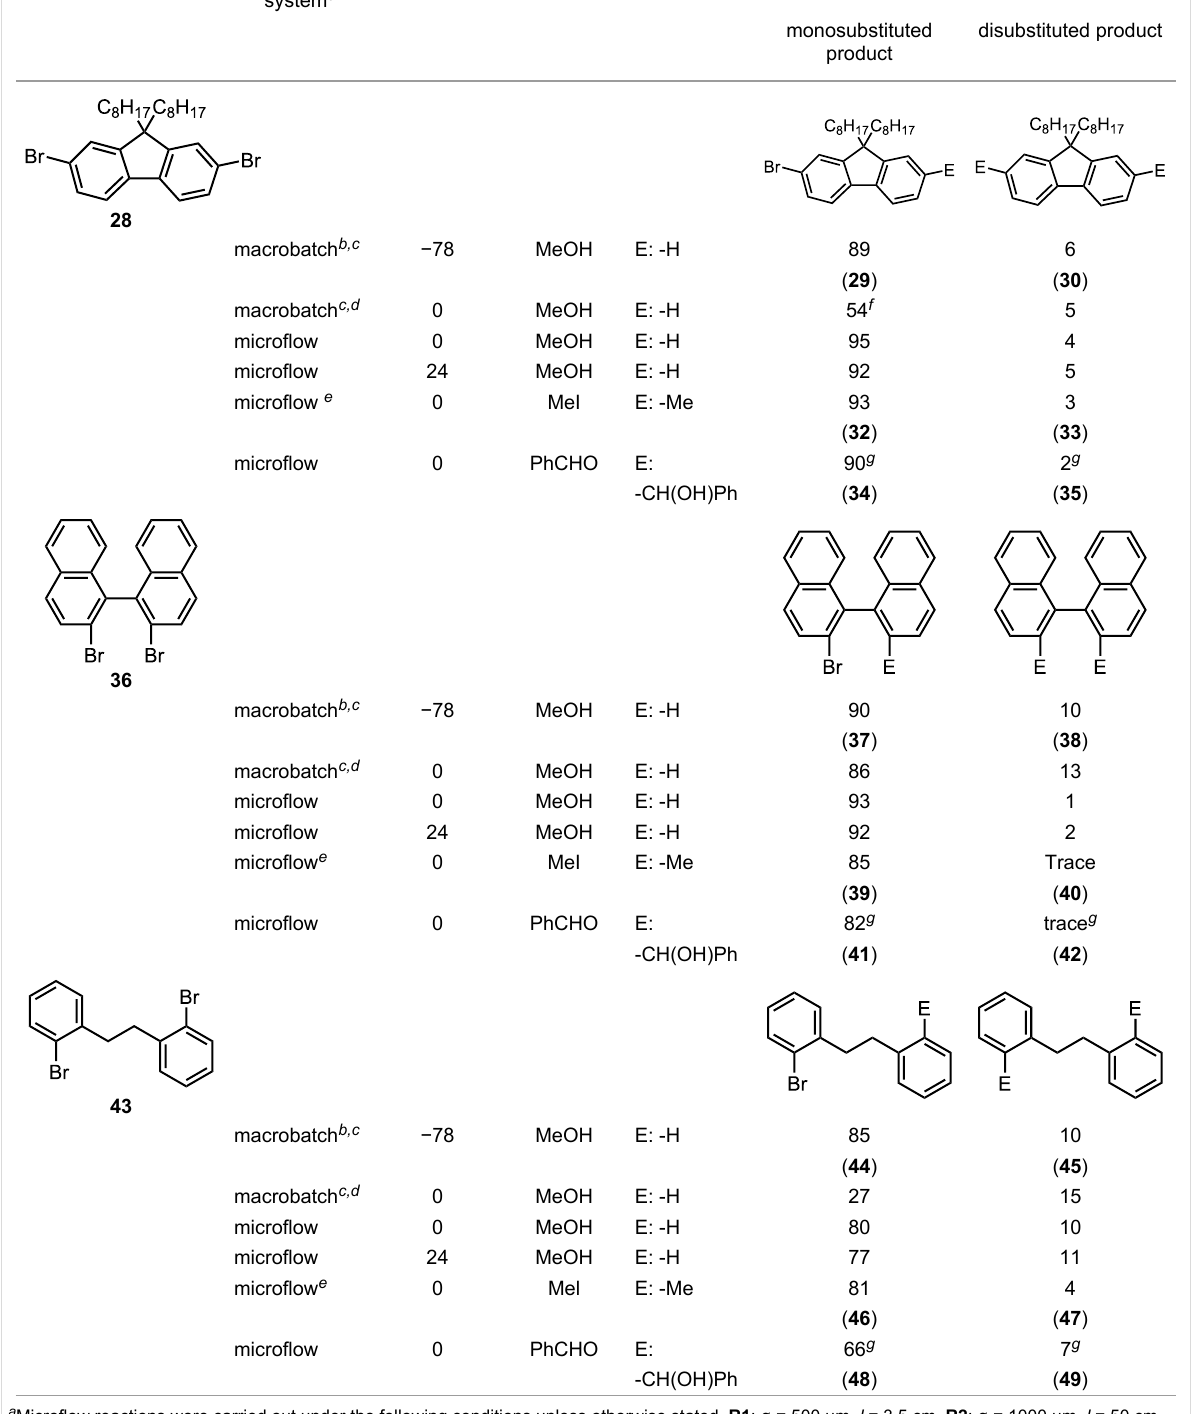
Table 8: Br-Li exchange reaction of other dibromobiaryls ( 28 , 36 ) and 2,2′-dibromobibenzyl ( 43 ) followed by reactions with electrophiles. dibromo